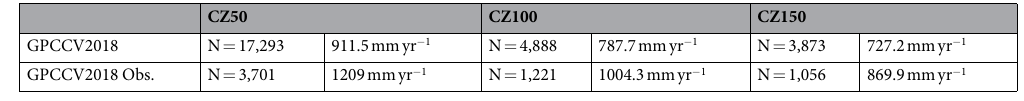
Table 1. Number of grid boxes and 1931–2010 mean annual precipitation for CZ50, CZ100, and CZ150 for the GPCC V2018 analysis product and the GPCC V2018 observation-only product.